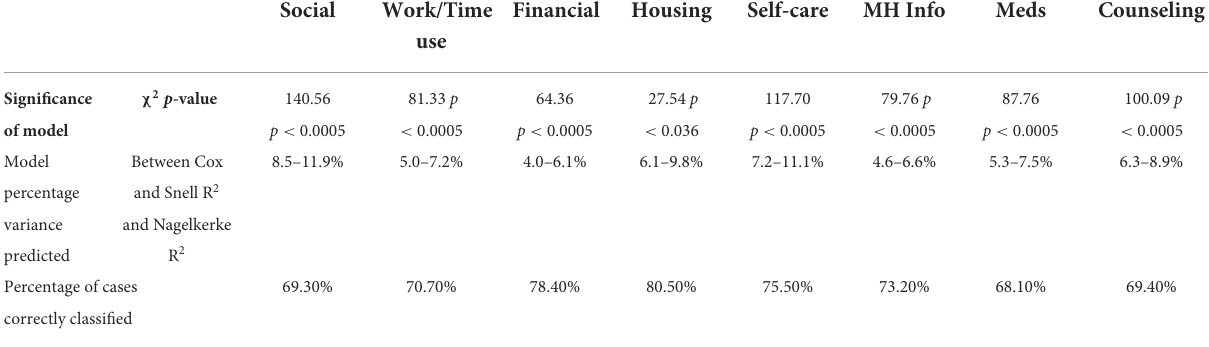
TABLE 5 Logistic regression models